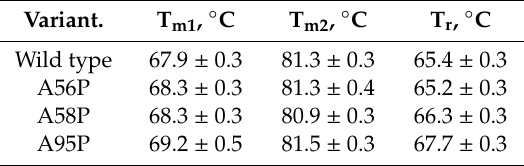
Table 1. Melting temperatures of CagFbFP and its proline mutants. T m1 and T m2 correspond to the two melting transitions (Figure 3), and T r corresponds to the temperature of refolding. Errors are standard deviations of the values observed in four independent experiments. Variant.